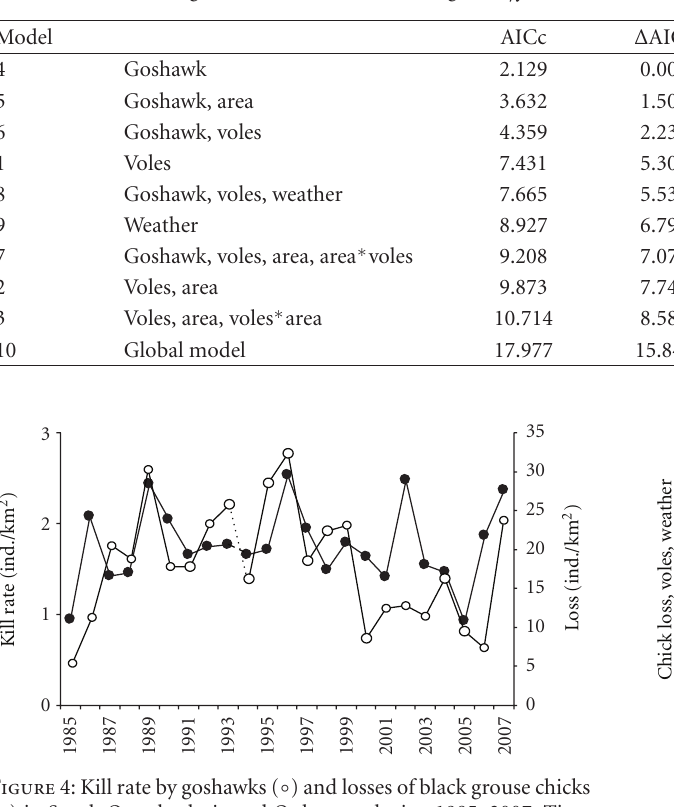
Table 2: Generalised linear models explaining variation in chick losses (upper panel) in study areas of South Ostrobotnia and Oulu area in western Finland during 1985–2007. LRT denotes log ratio χ 2 test for model e ff ect.